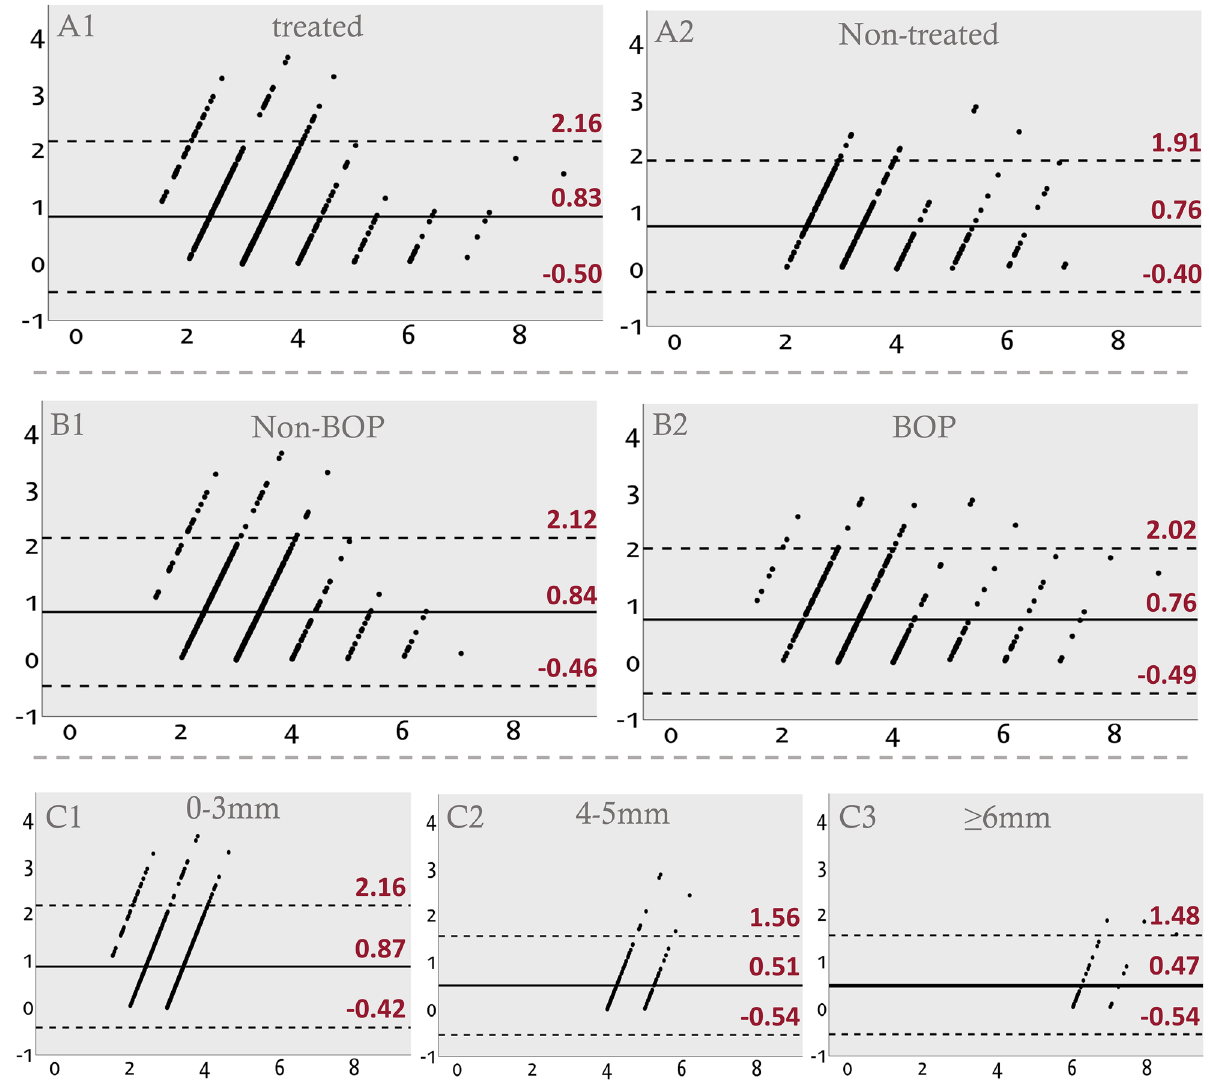
Figure 2. Bland–Altman plots for each group according to clinical features affecting the clinical PD. (A1) Sites treated for periodontitis. (A2) Sites with periodontitis that were not treated. (B1) Sites without BOP. (B2) Sites with BOP. (C1) Sites with a PD of 0–3 mm. (C2) Sites with a PD of 4–5 mm. (C3) Sites with a PD of ≥ 6